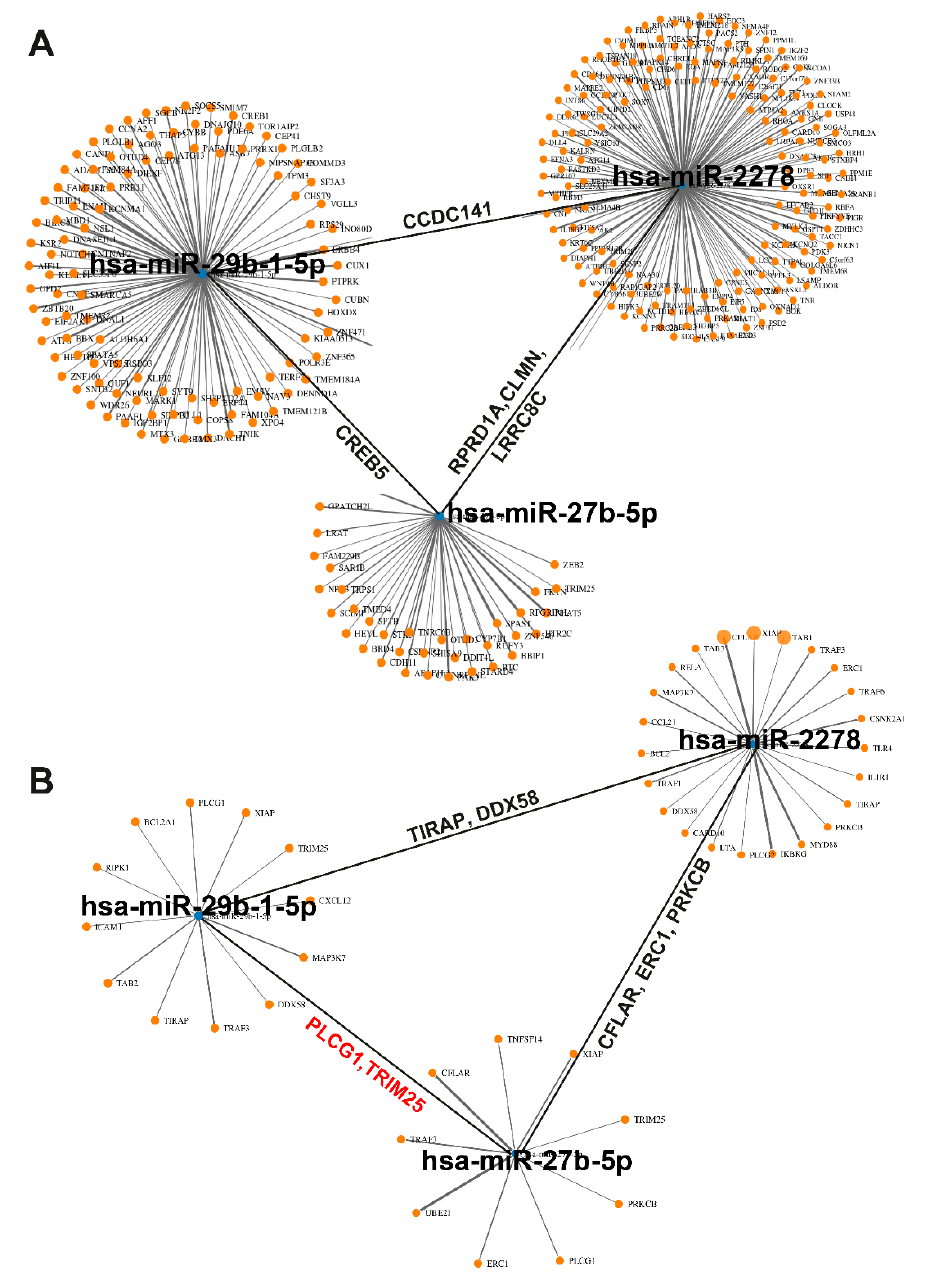
Figure 7. Identification of NF- κ B-related miRNA-target genes. ( A ) Using the Target Mining option of the mirWalk online platform, 309 target genes of miR2278, miR27b-5p, and miR29b-1-5p were identified and displayed as a network graph. Each orange dot is associated to a target gene. The black lines symbolize, e.g., the joint target gene CCDC141 of miR2278 and miR29b-1-5p, the joint target gene CREB5 of miR-29b-1-5p, and the joint target genes RPRD1A, CLMN, and LRRC8C of miR-2278 and miR27b-5p. ( B ) An miRNA-target gene analysis with focus to NF- κ B signaling identified the most significantly NF- κ B-related target genes of miR29b-1-5p, miR2278, and miR27b-5p. TIRAP and DDX58 are target genes of miR2278 and miR29b-1-5p, CFLAR, ERC1, and PRKCB are target genes of miR2278 and miR27b-5p, and PLCG1 and TRIM25 are target genes of miR29b-1-5p and